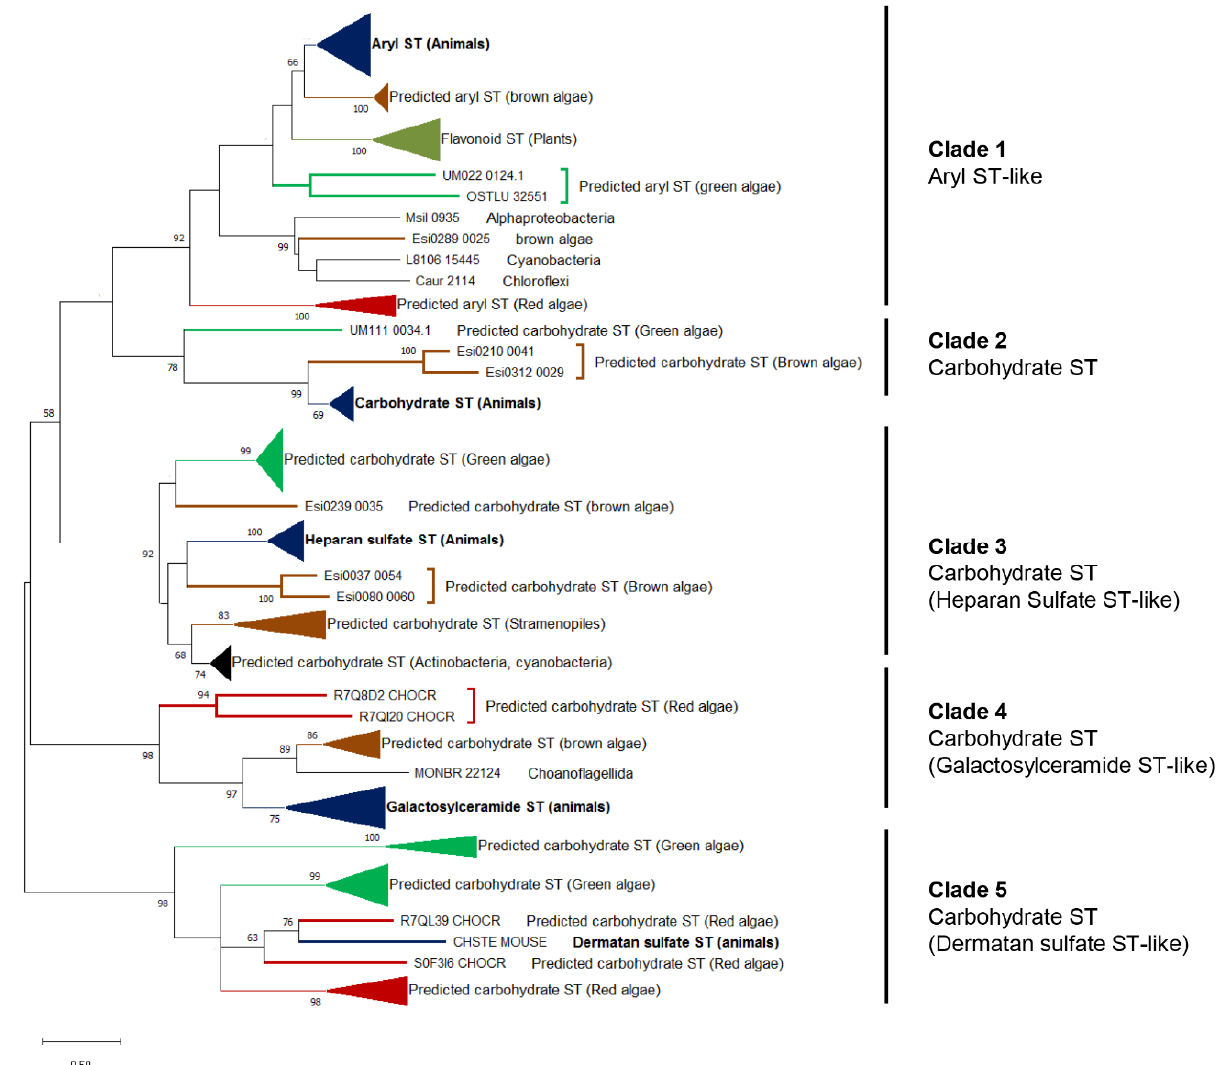
Figure 4. Unrooted phylogenetic tree of eukaryotic sulfotransferases. The phylogenetic tree was constructed using the Maximum Likelihood (ML) approach with the program MEGA-X [82]. Numbers indicate the bootstrap values in the ML analysis. Bootstrap values inferior to 50% are not shown. The sequence labels in bold correspond to biochemically characterized sulfotransferases. The full listing of the aligned proteins is reported in Supplementary Table S1. The uncompressed tree is shown in Supplementary Figure S2.